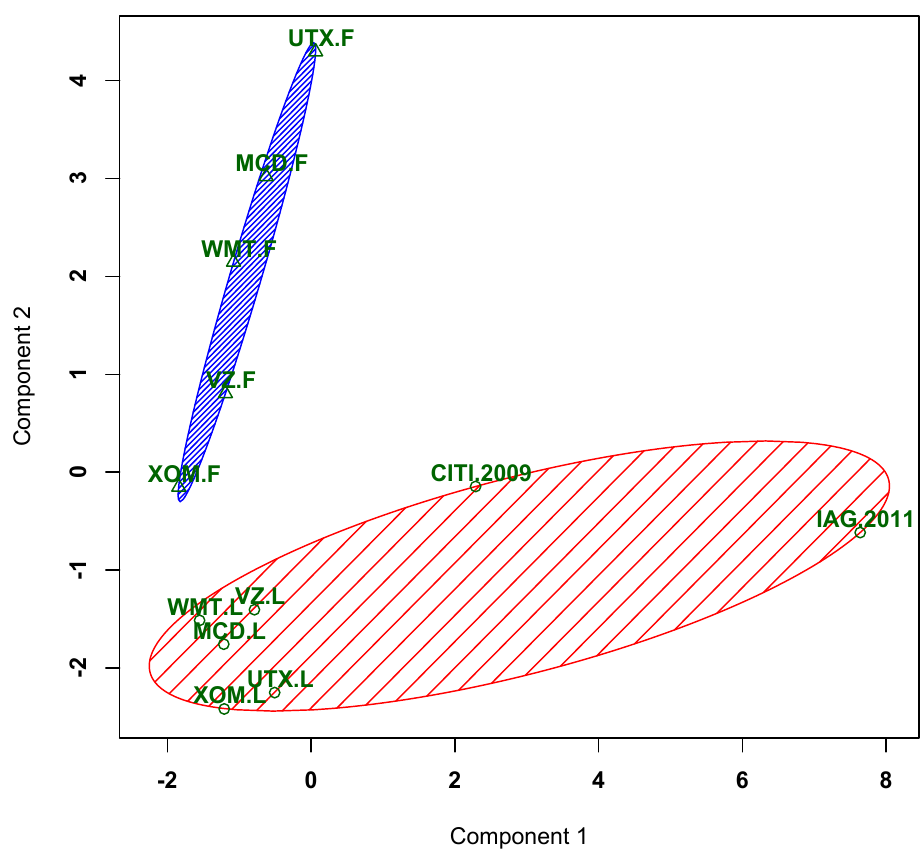
These two components explain 88.66 % of the point variability. Figure 8. Clustering results for the Lehman Brothers collapse, flash crash event, Citigroup (2009), and IAG (2011) stock data based on symmetric divergence using the PAM